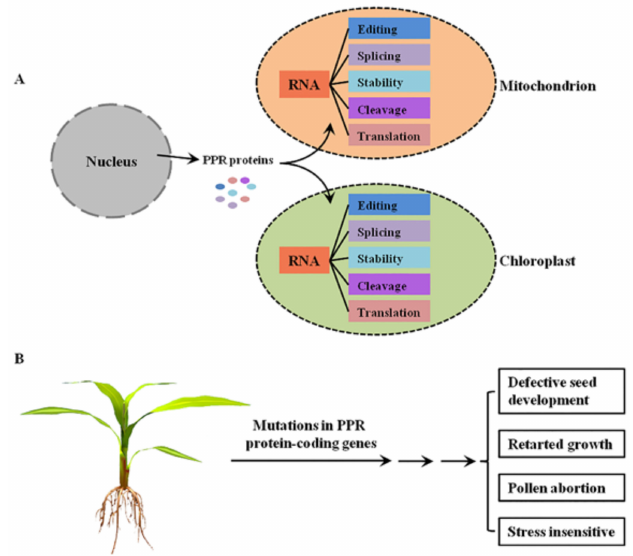
Figure 1. The functions of PPR proteins in plants. ( A ) The molecular functions of PPR proteins in plant mitochondria and chloroplasts. PPR proteins are encoded by nuclear genes, translated in the cytoplasm, and then imported into mitochondrion or chloroplast to mediate multiple steps of RNA processing. ( B ) The main growing and developmental phenotypes of plant mutants of PPR protein-coding